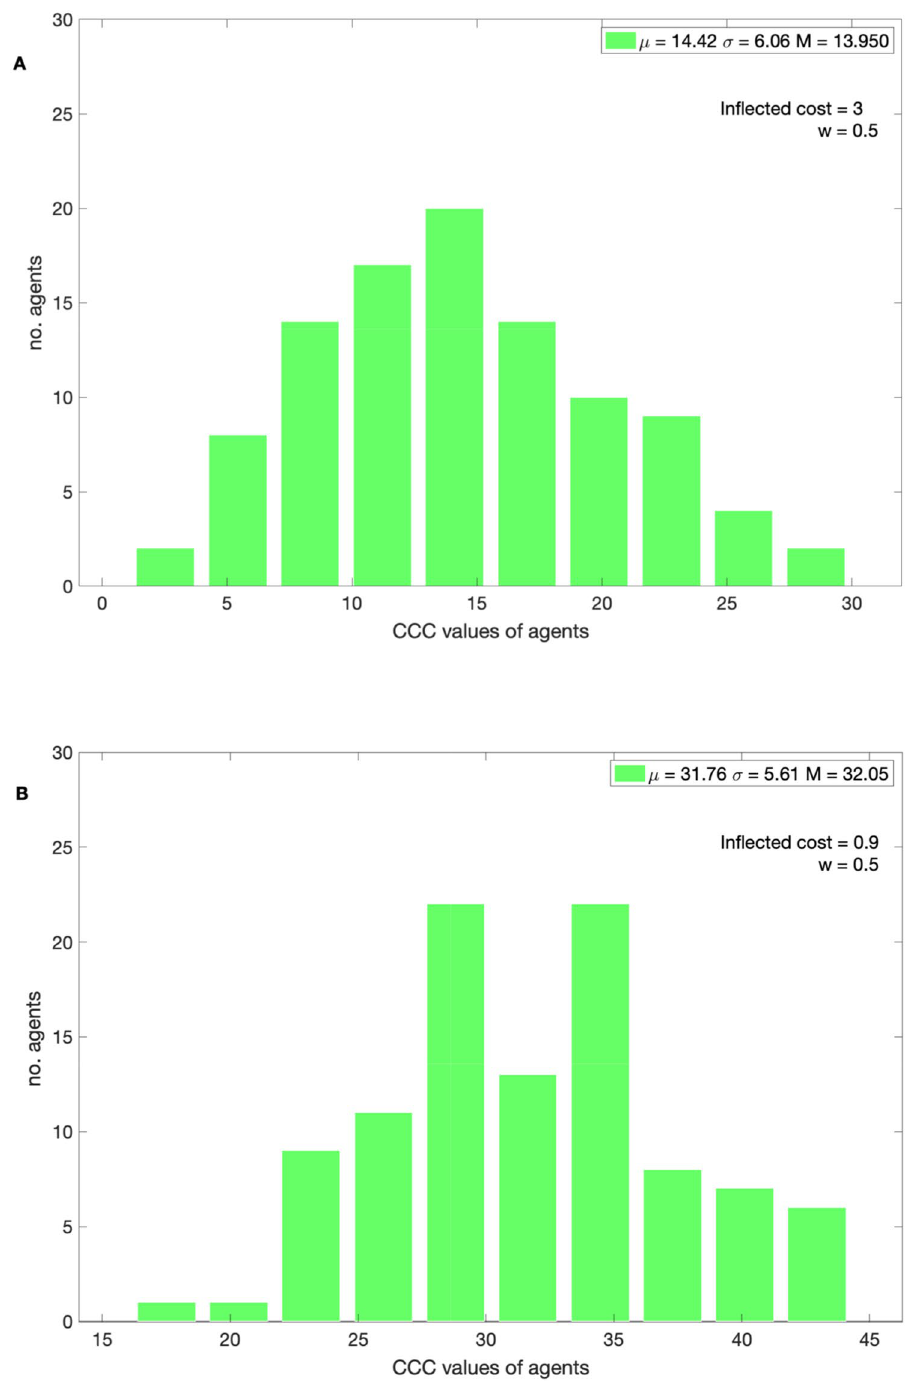
Figure 4. The distribution of CCC values in the 20,000th generation with a bin size of 10. With w = 0.5 ( A ) (cost) = 3 and with ( B ) (cost) =